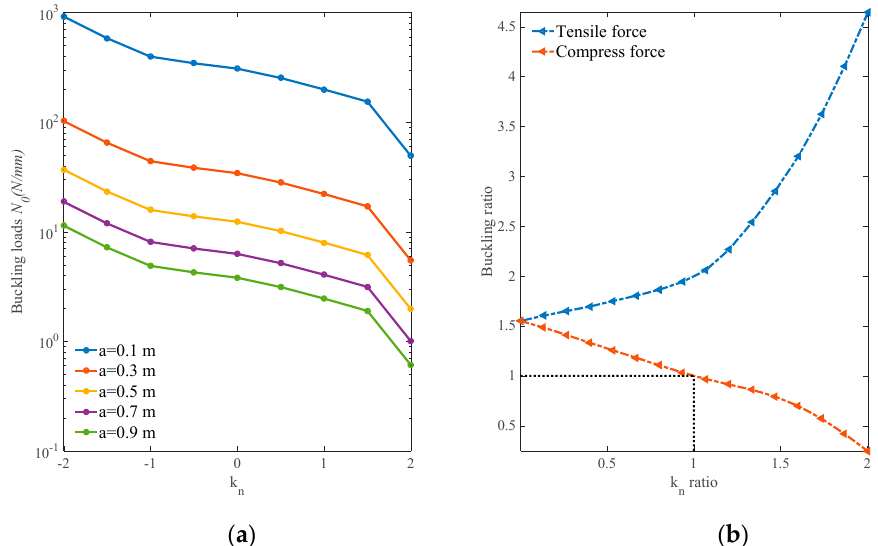
Figure 3. Buckling loads affected by axial force parameter. ( a ) k n vs. Buckling loads, and ( b ) k n ration vs. Buckling load ratio.